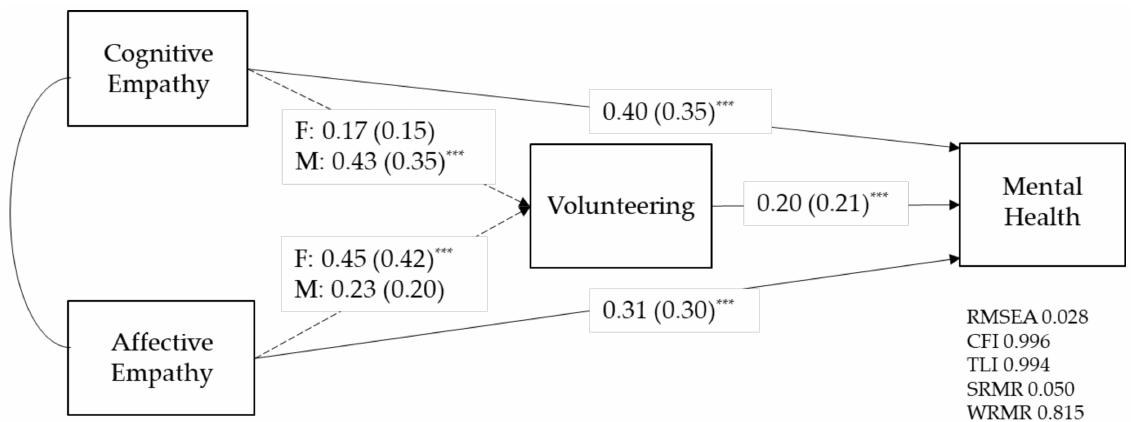
Figure 2. Results from group analysis by gender. Note: Standardized path coefficients are presented in parentheses. Dash lines exhibit the paths showing gender differences. *** p <